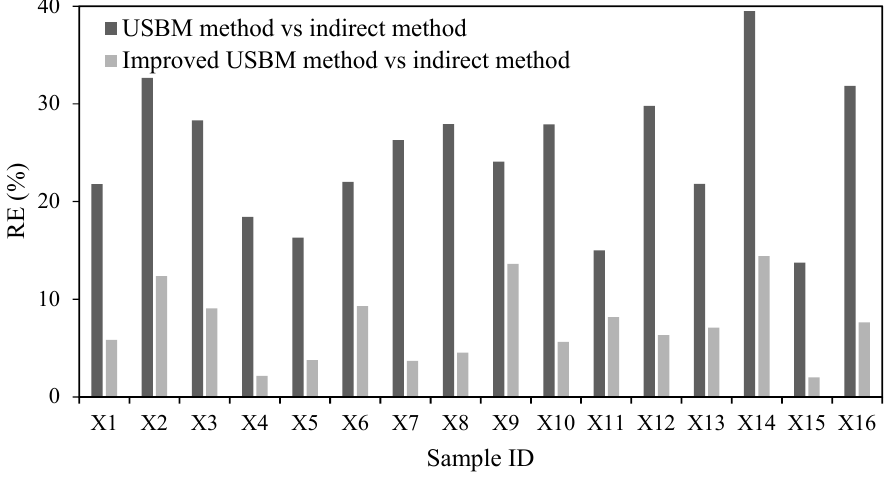
Figure 13. The results of relative error (RE).